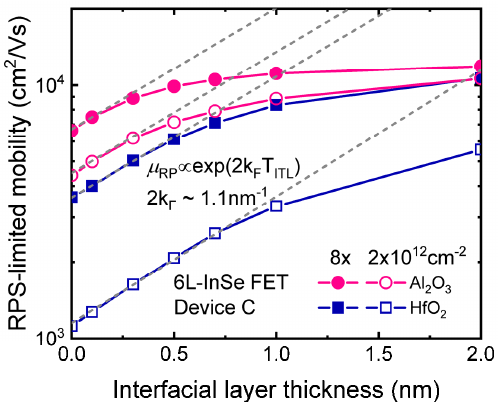
Figure 8. Remote coulomb scattering (RCS)-limited mobility as a function of SiO 2 interfacial layer thickness corresponding to total mobility in Figure 7b, showing an exponential dependence on T ITL as exp(2 k F T ITL ) with 2 k F = 1.1 nm − 1 , represented by the dashed lines.